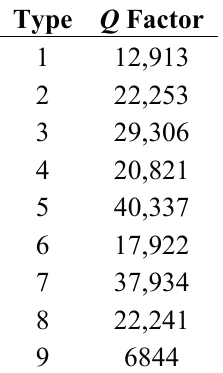
Figure 14. Nine types of TF-probe structures. Table 6. The impact of the gluing forms on the Q